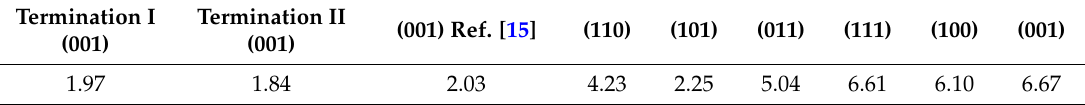
Table 1. The calculated surface energies (eV/Å 2 ) of different LaNiO 3 surfaces.